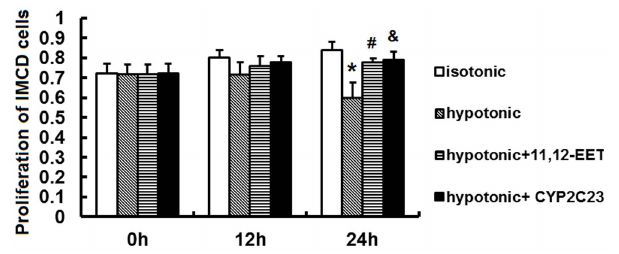
Figure 3. Proliferation assessed by MTT assay. The results of MTT assay on assessing the effect of 11,12-EETs (100 ng/ml) or Ad-CMV- CYP2C23-GFP (100 MOI) transfection on the proliferation of IMCD cells exposed to 0 h,12 h or 24 h hypotonic stress. *, P , 0.05 compared with isotonic group. # , P , 0.05 compared with hypotonic group. &, P , 0.05 compared with hypotonic group. Error bars represent the standard deviations based on three independent replicates.